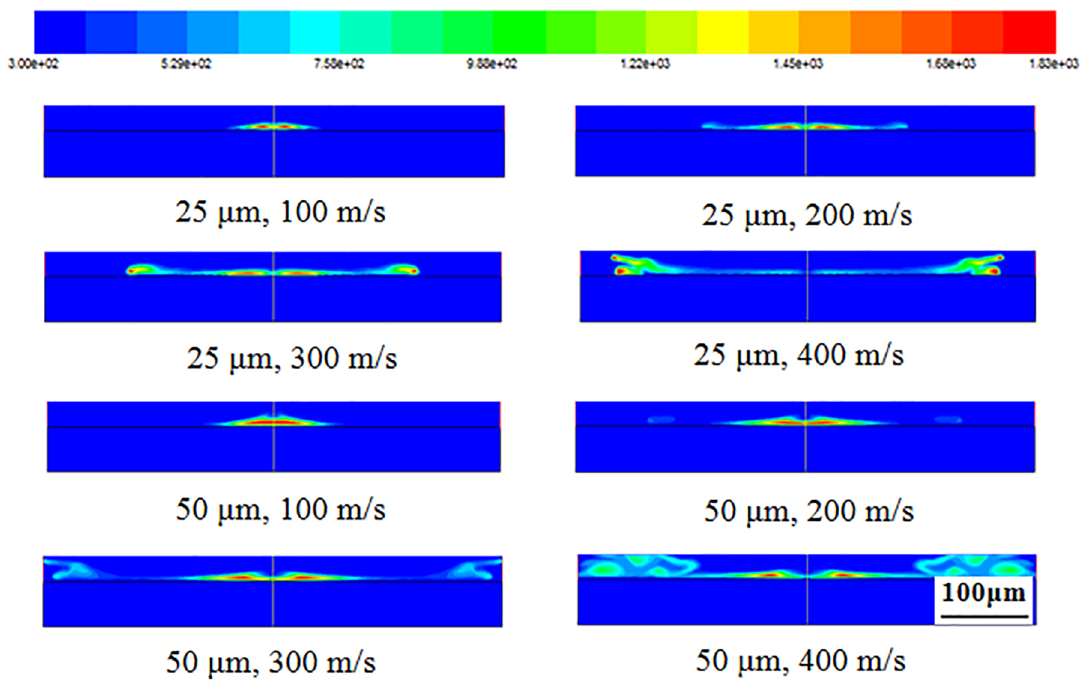
Figure 8. Change of solidification temperature field of TWAS droplet at 1 μs.